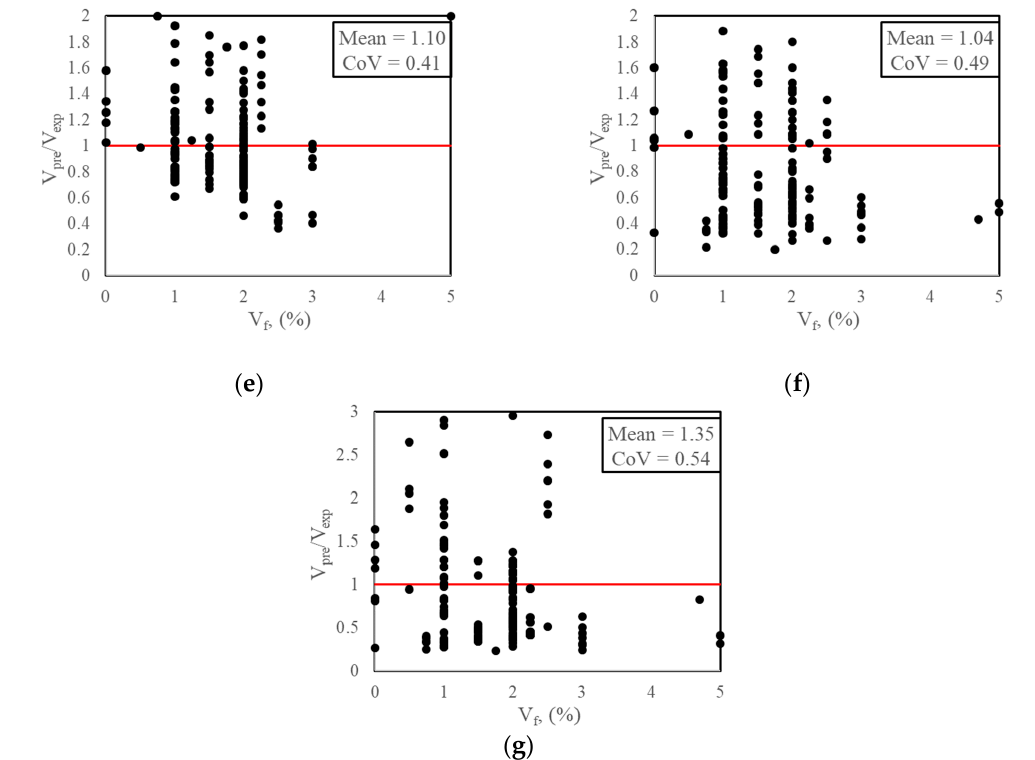
Figure 8. Distribution of the ratios (V pre /V exp ) obtained by different methods. ( a ) ANN; ( b ) SVR; ( c ) XGBoost; ( d ) Qi et al.; ( e ) Ahmad et al.; ( f ) CECS 38:2004; ( g ) Sharma et al. Table 2. Accuracy evaluation details of the above prediction methods.